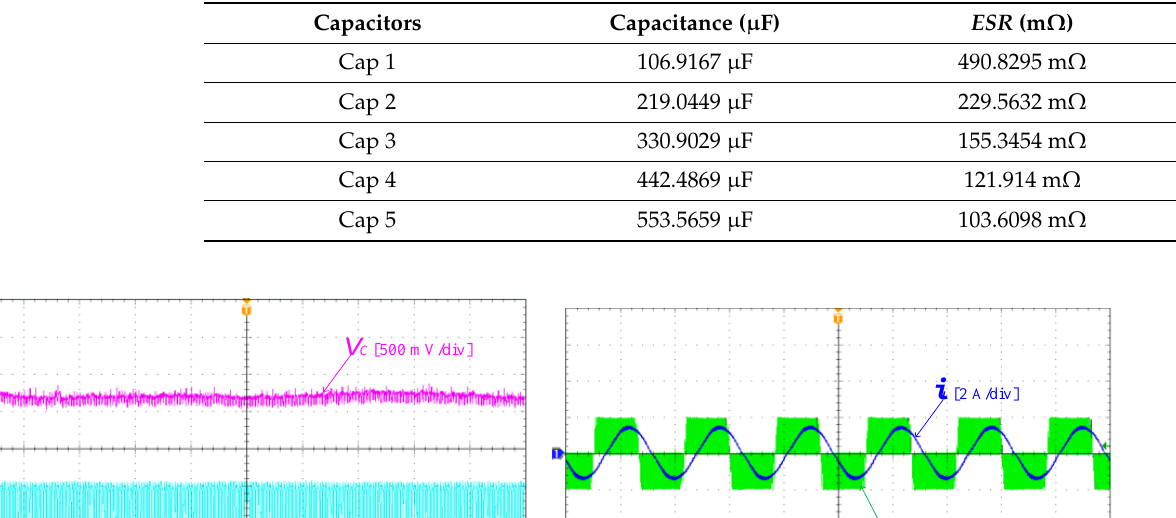
Table 2. Capacitor Parameters.